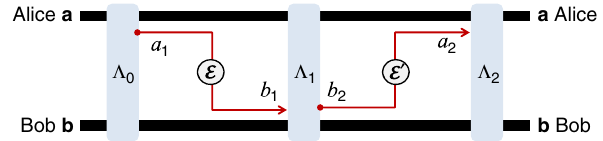
Figure 10 | Adaptive protocol for two-way quantum or private communication. The protocol employs a forward channel E and backward channel E 0 . Transmissions are alternated with adaptive